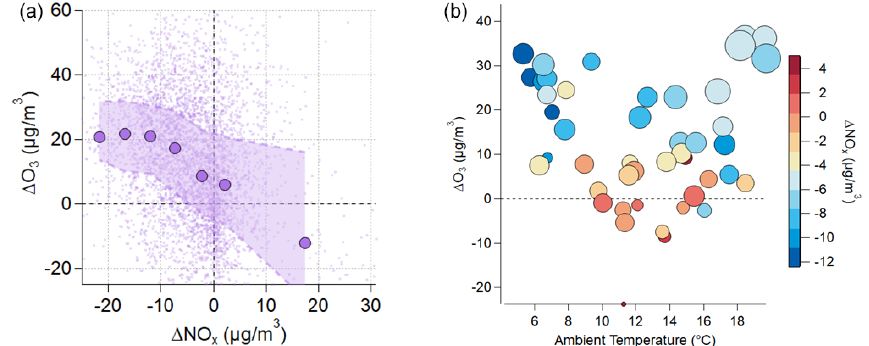
Figure 7. (a) Concentration change (µg/m 3 ) of O 3 versus concentration change of NO x (µg/m 3 ). Colored dots correspond to 100 resampling runs following the inverse normal distribution law, whose mid-height width is the standard deviation of each analog day. Markers represent the median, bottom and top and the shaded area the 25th and 75th percentile, respectively. (b) Concentration change of O 3 versus ambient temperature. Marker’s color and size are respectively function of (cid:49) NO x and observed O 3 concentrations.